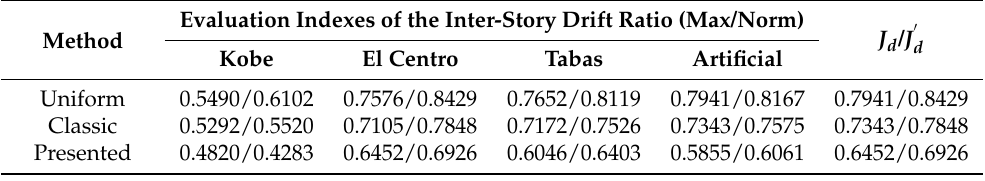
Table 7. Evaluation indexes of the inter-story drift ratio under different seismic